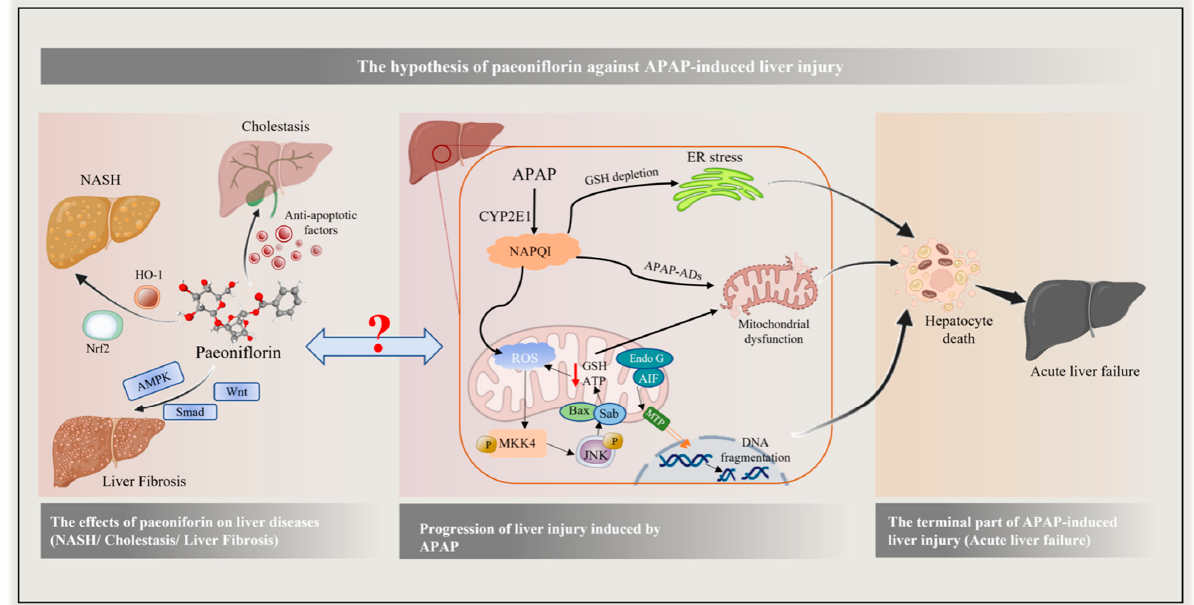
Figure 1. The hypothesis of paeoniflorin against APAP-induced liver injury. The pathogenesis of APAP is complex, which can induce hepatocyte death through multiple regulation, and then lead